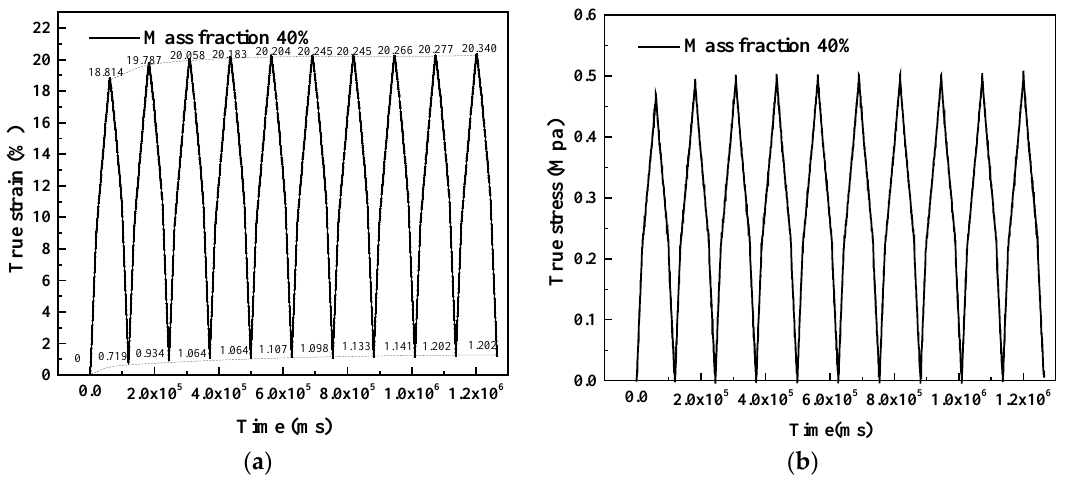
Figure 12. True strain and stress versus time in load-unload test: ( a ) Strain versus time; ( b ) Stress versus time.